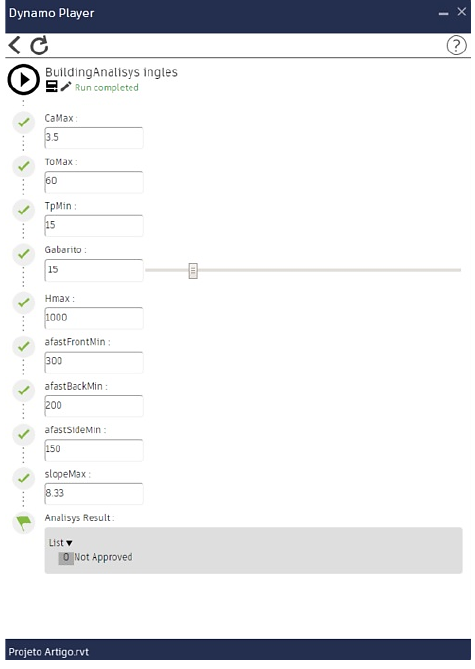
Figure 11. Input/output in Dynamo Player.